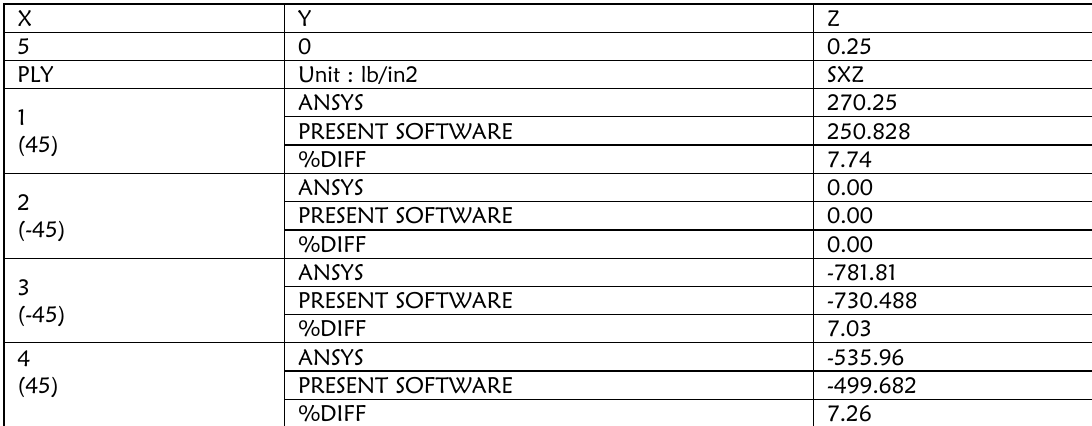
Table 6: Shear stress on the web of C-beam due to